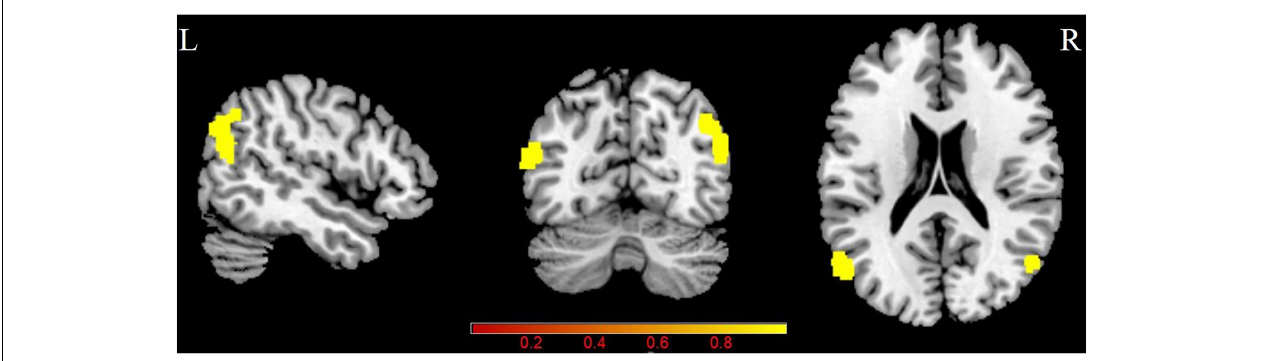
FIGURE 1 | Group differences in CBF/ReHo ratio between patients with PT and NCs ( P < 0.05, FDR corrected). PT: pulsatile tinnitus; NC: normal control; CBF: cerebral blood flow; ReHo: regional homogeneity.